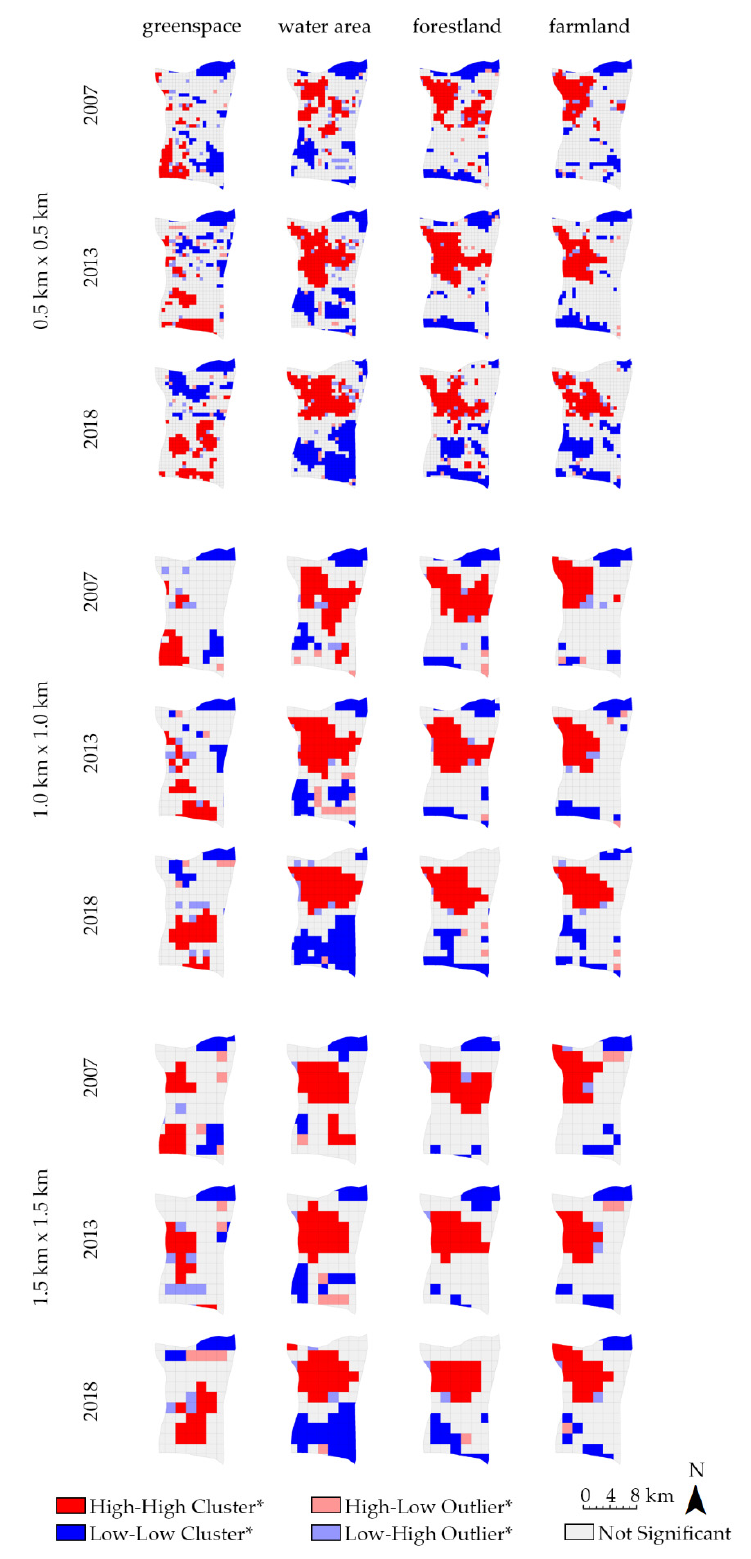
Figure 6. The LISA clustering map of LSI for different GI. Note: * indicates 95% confidence interval ( p < 0.05).